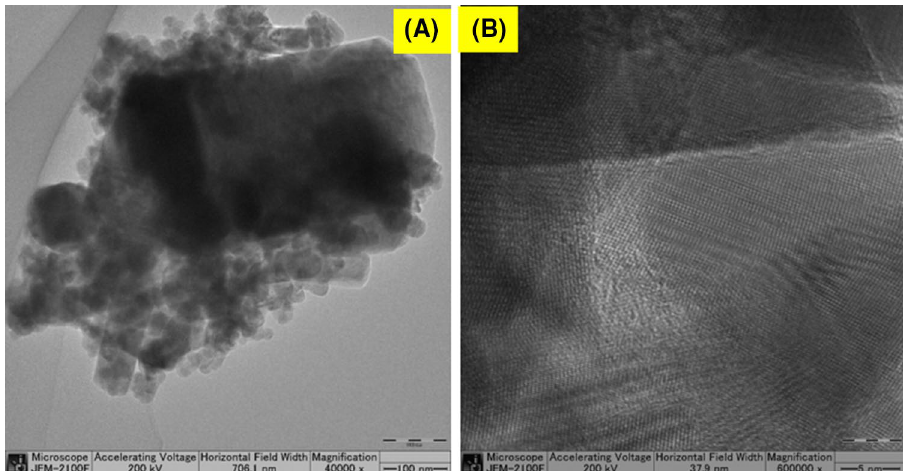
Fig. 5 HRTEM images of as- obtained CeO 2 /PbWO 4 NCs